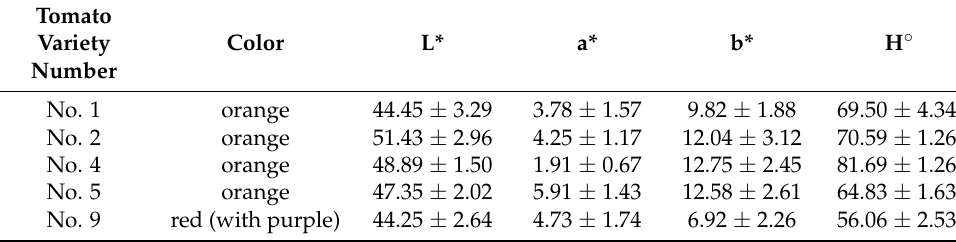
Table A3. The color parameters of No. 1, 2, 4, 5 and 9 tomato varieties. Tomato